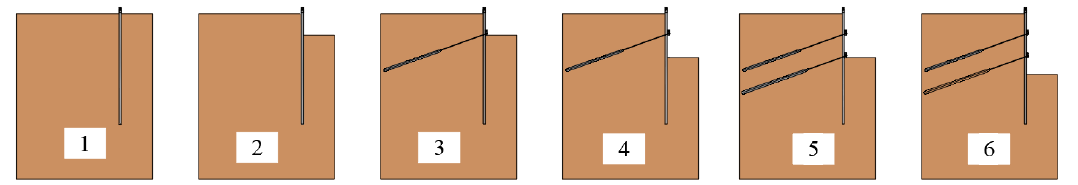
Figure 3 - Retaining wall building